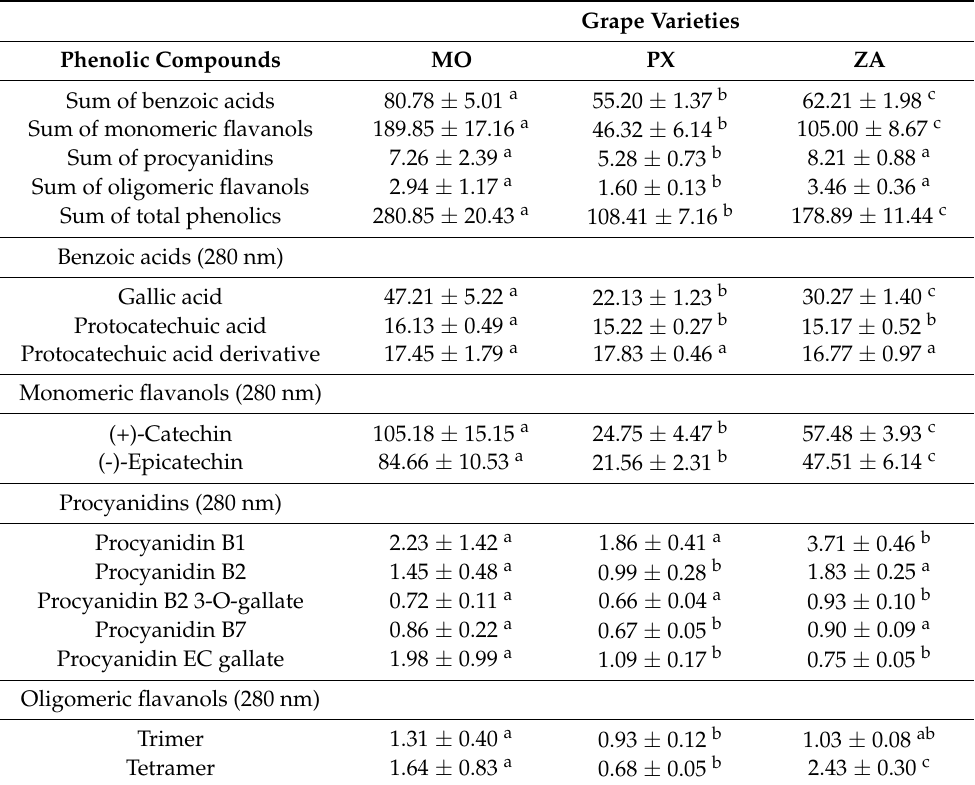
Table 1. Phenolic composition (mean values ± SD, n = 10) of overripe seeds according to grape variety (MO: Moscatel, PX: Pedro Xim é nez, ZA: Zalema) determined by rapid resolution liquid chromatography/mass spectrometry